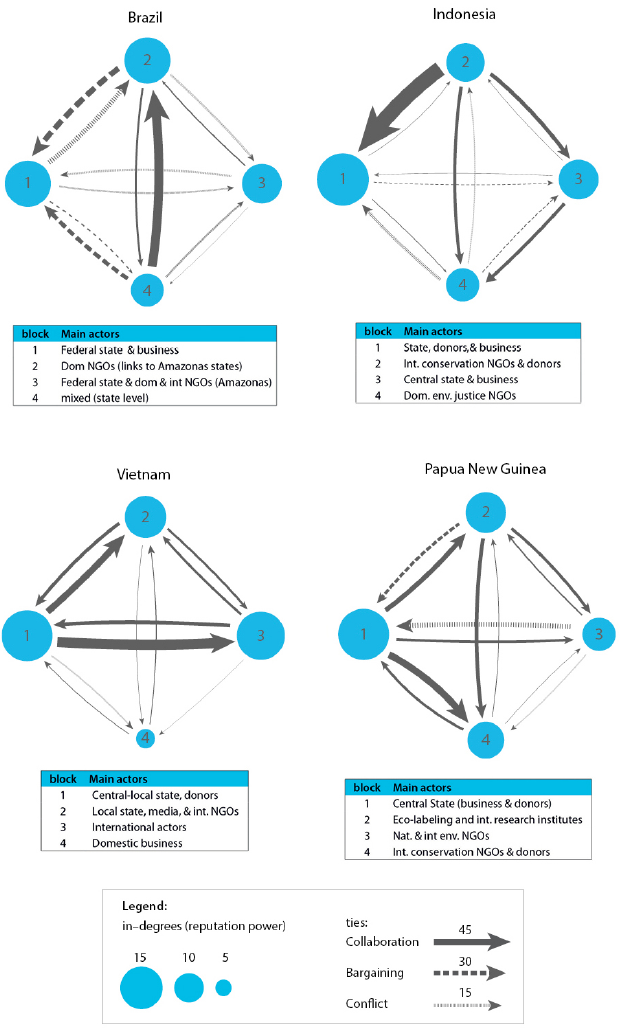
Fig. 5 . Patterns of interactions in national REDD+ policy